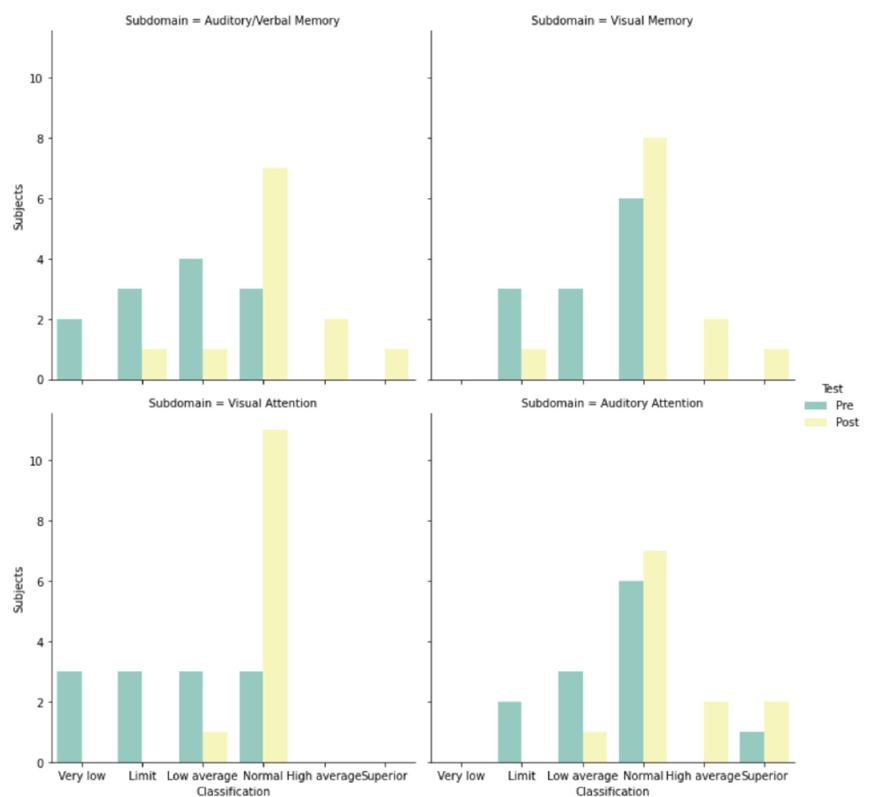
Figure 4. Pre-test and post-test classification results for each subdomain.